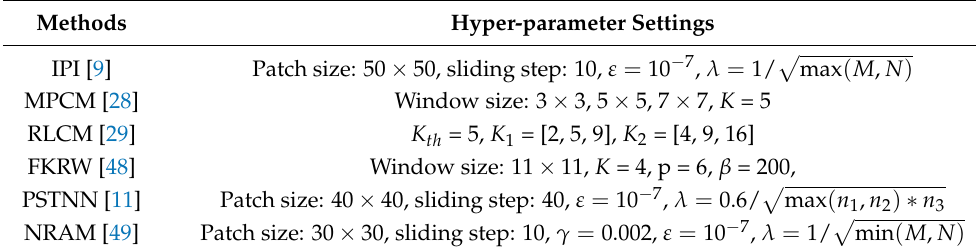
Table 2. Hyper-parameters settings of the model-driven methods..